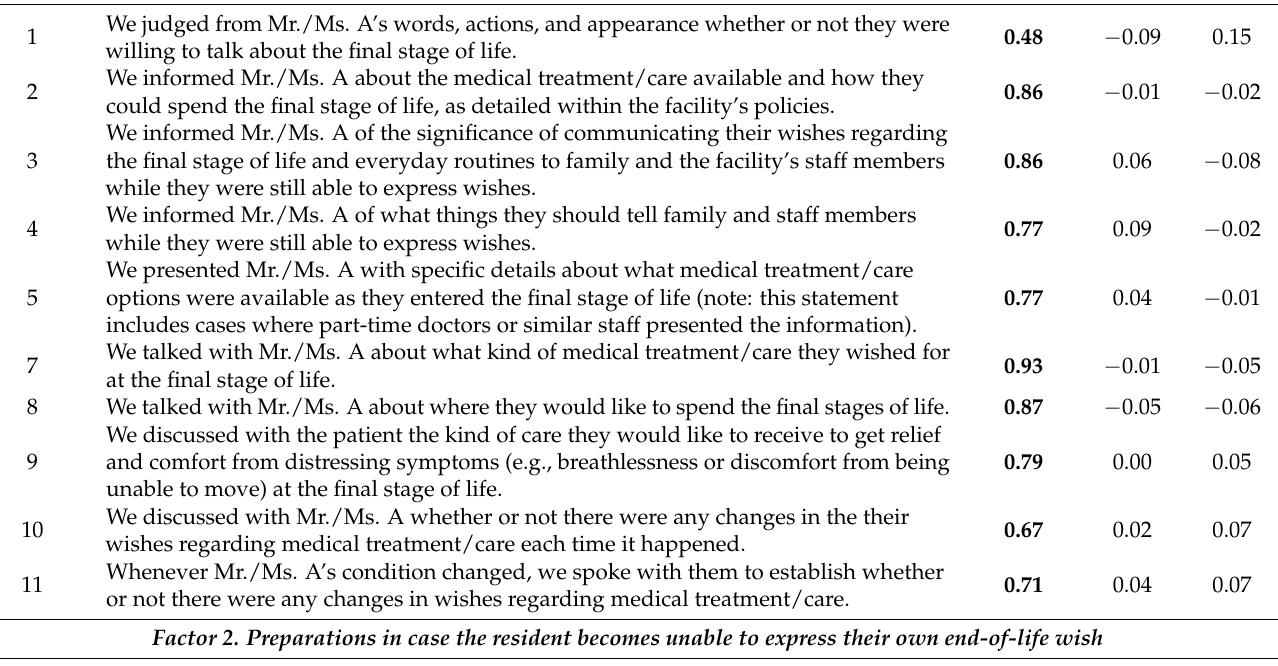
The ways in which I explained the final stage of life were modified depending on Mr./Ms. A’s cognitive functions. When discussing the final stage of life with Mr./Ms. A, we checked that they understood the content.